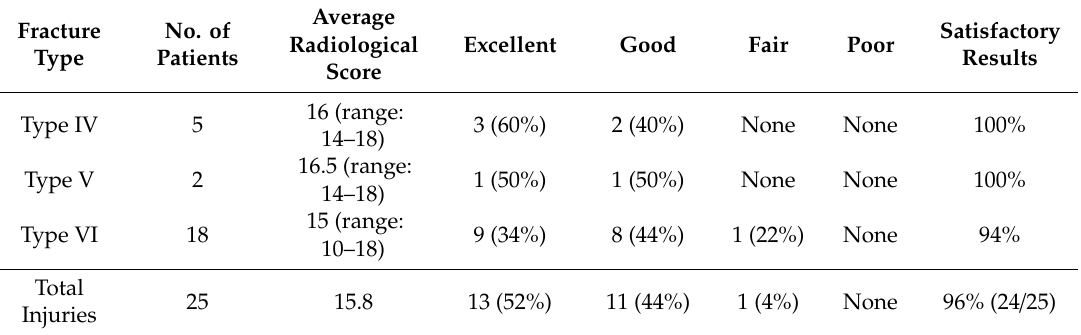
Table 5. Results of radiological assessment in 25